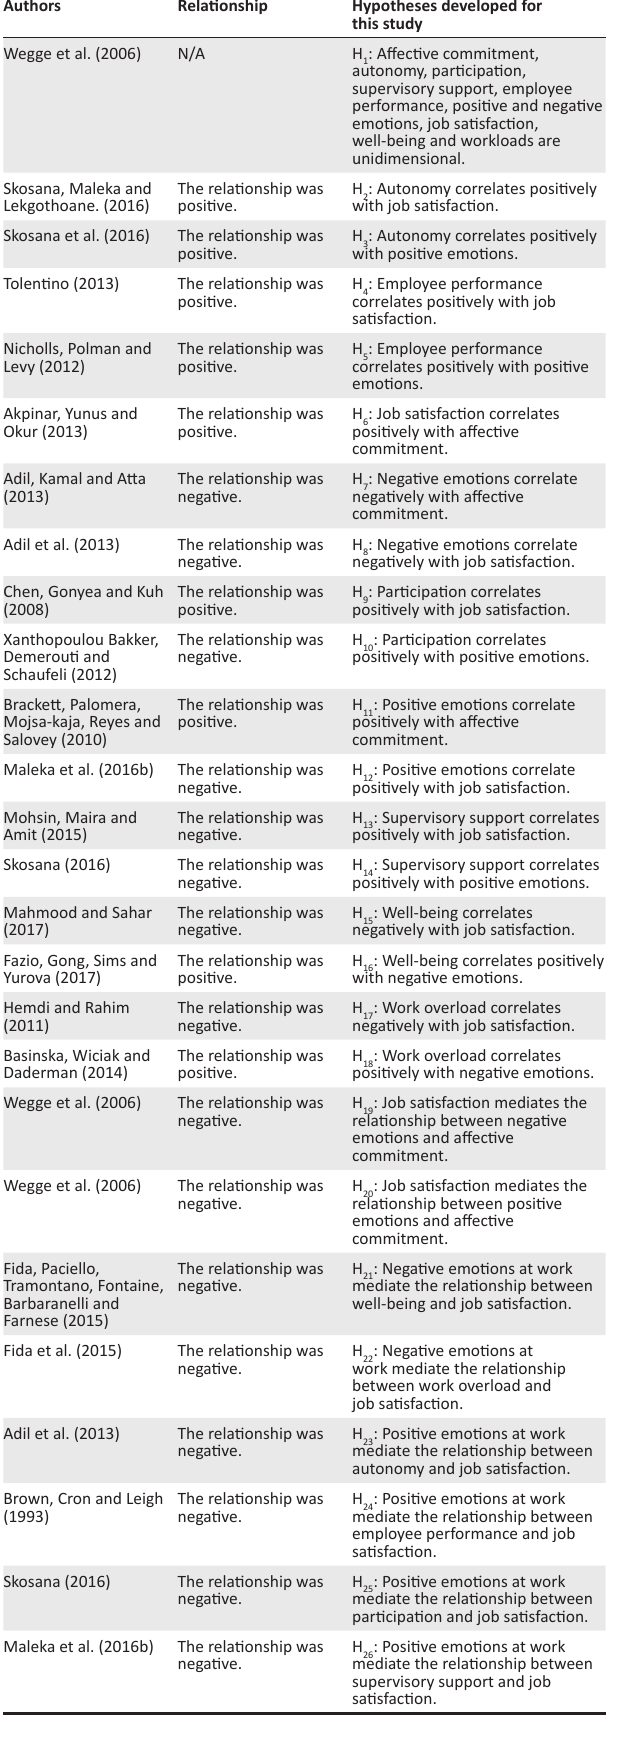
TABLE 1: Previous research on study